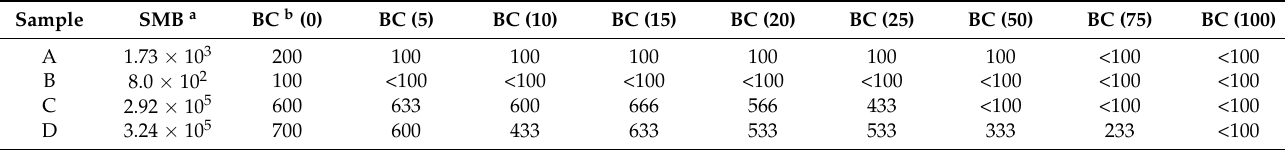
Table 1. Spore-forming mesophilic bacteria (SMB) and presumptive B. cereus s.l . counts in Mexican chili powder samples.